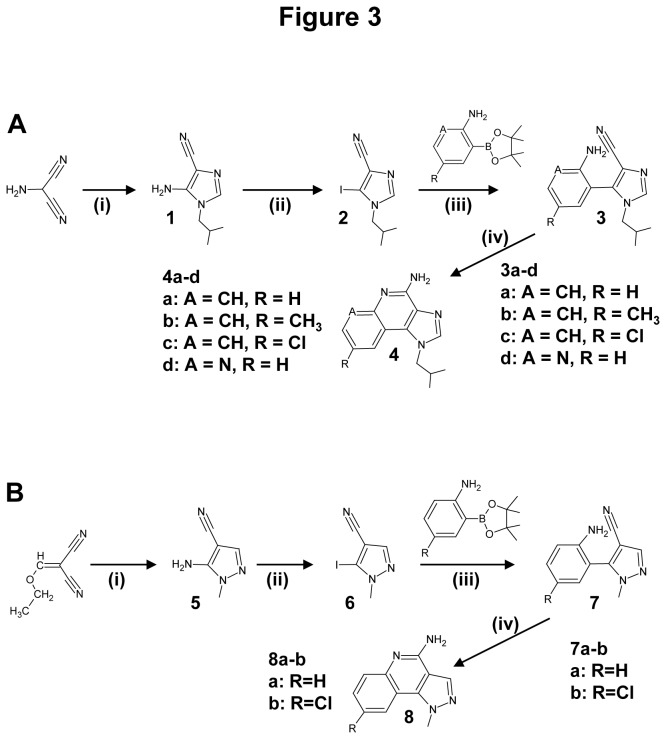
Reagents and conditions for the preparation of IQ and its chemical derivatives.
A. (i) Step 1: CH(OEt)3, CH3CN 30 min reflux; Step 2: (iso-butylamine) 12h 20°C; (ii) CH2I2,
iso-pentylnitrite; (iii) 2N Na 2CO3, Pd[(P(C6H5)3]4, dioxane; (iv) NaNH2, toluene, 2h at 80 °C. B. (i) CH3NHNH2, NEt3, THF, 60 °C; (ii) CH2I2, iso-pentylnitrite; (iii) 2N Na 2CO3, Pd](P(C6H5)3]4, dioxane, 80 °C; (iv) NaNH2, toluene.